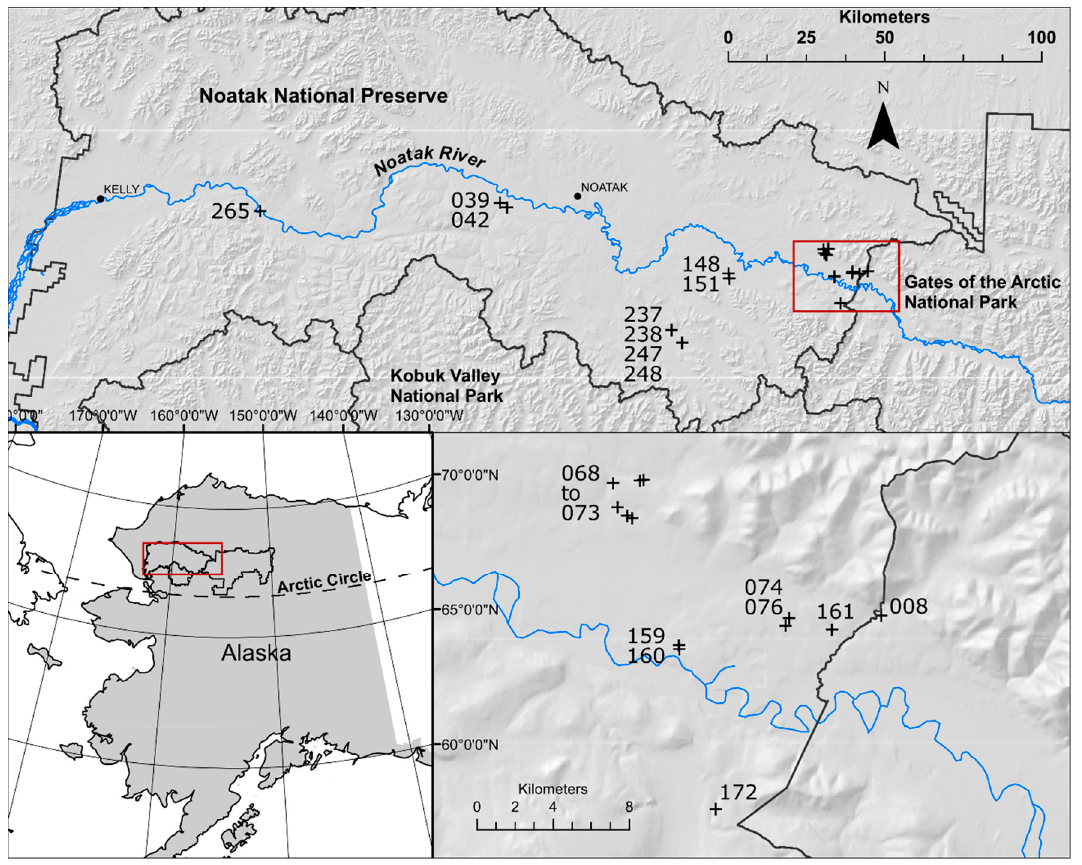
Figure 2. Location of the study area. The study slumps are marked with a plus sign (+) and labeled with the three digits from the slump identifiers used in the text and tables. The inset maps show the overall location (lower left) and detail of the slump-rich portion of the eastern Noatak Valley (lower right). Locations of the Kelly and Noatak RAWS (weather stations) are also shown.